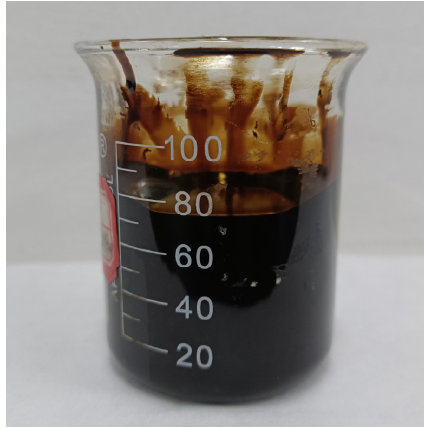
Figure A1. 0# diesel.